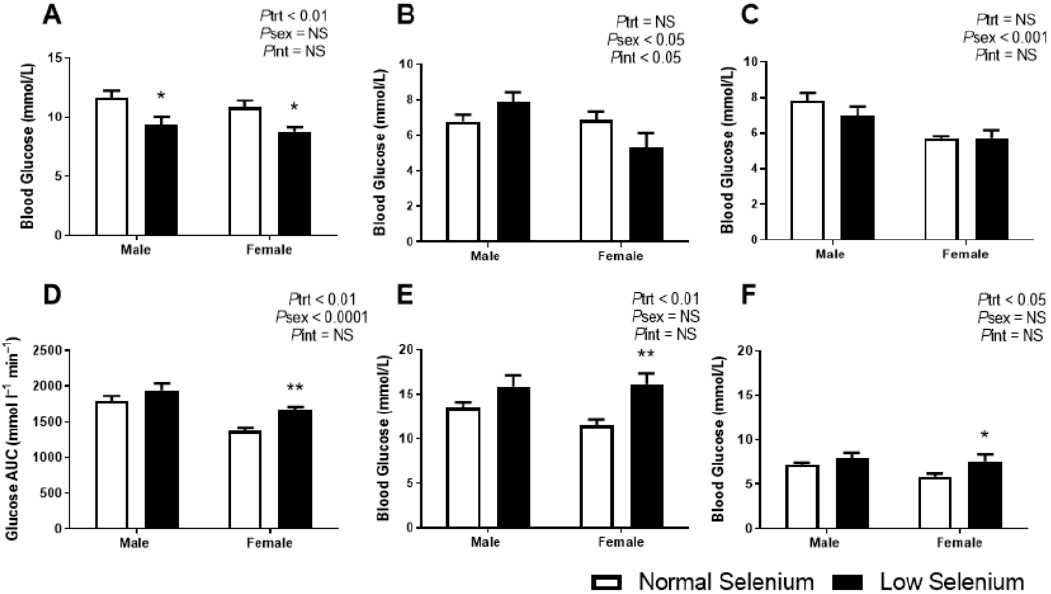
Figure 2. Offspring glucose metabolism. Offspring random glucose concentrations at ( A ) PN30 and fasting blood glucose concentrations at ( B ) PN90 and ( C ) PN170. Following an intraperitoneal (IP) of glucose at PN170, the following parameters were determined: ( D ) GTT area under the glucose curve (AUGC), ( E ) peak blood glucose concentrations 30 min post IP and ( F ) blood glucose concentrations 180 min post IP. Open bars (white) indicate offspring from litters that consumed a normal selenium diet, whereas closed bars (black) are offspring from litters that consumed a low selenium diet throughout pregnancy and up until weaning. Data are mean ± SEM and analysed by two-way ANOVA with treatment ( P trt ) and sex ( P sex ) as major factors. P int represents the interaction between treatment and sex. Multiple comparisons were determined by Sidak posthoc testing. * = p < 0.05, ** = p < 0.01 compared to control of same sex. n = 6–9.